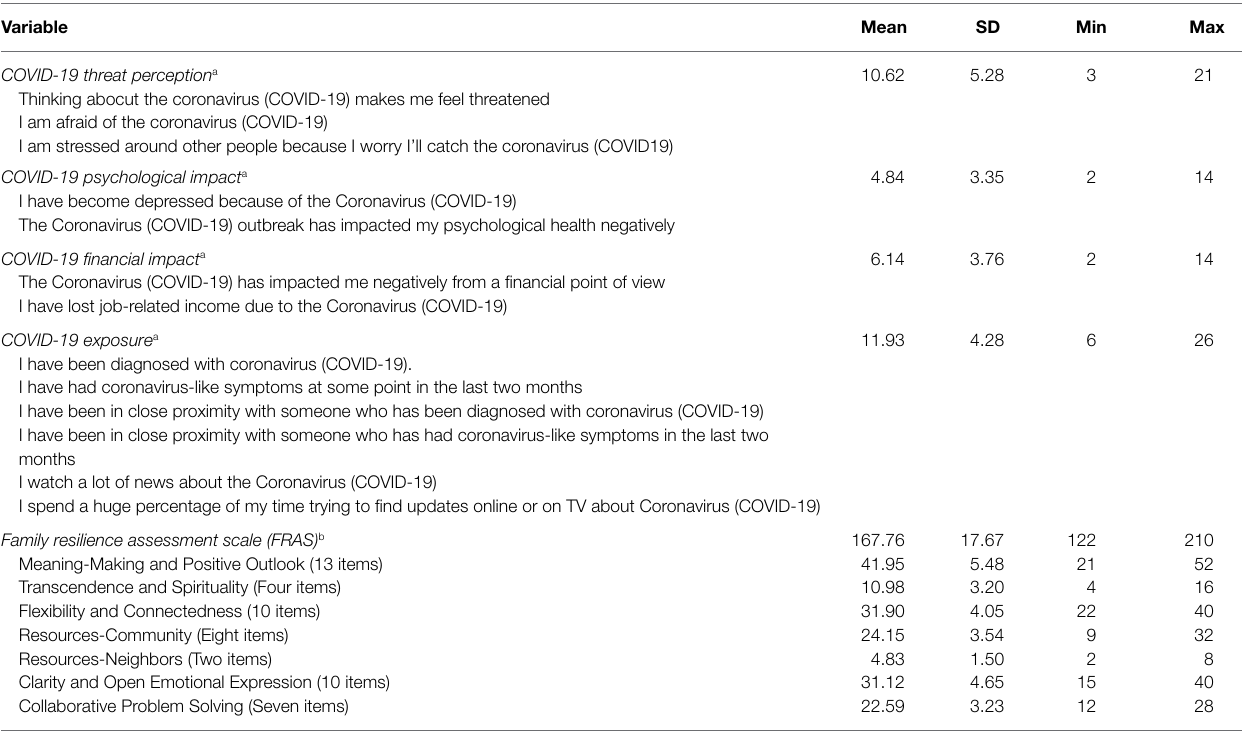
TABLE 1 | Descriptive statistics of the